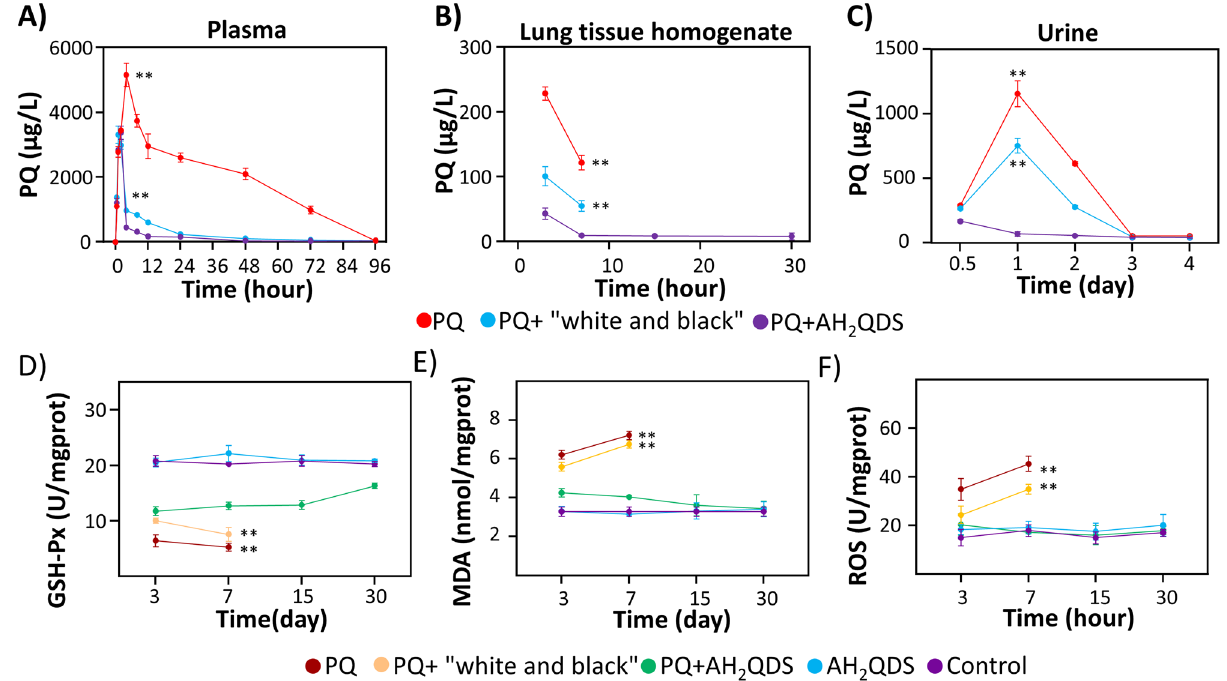
Figure 7. AH 2 QDS can decrease PQ drug concentration in vivo and improve the antioxidant reaction to oxidative stress. ( A – C ) The concentration of PQ in plasma, tissue and urine was detected by Ultra high- performance liquid chromatography-tandem mass spectrometry. ( D – F ) The levels of GSH-Px, MDA, and ROS were detected in different treatment groups. Due to a 4X LD50 dose of PQ intervention, animals in the PQ group and PQ + "white and black" group died within one week, so there is no subsequent time point data. Data are presented as means ± SEM, n = 3, *P < 0.05, **P < 0.001.